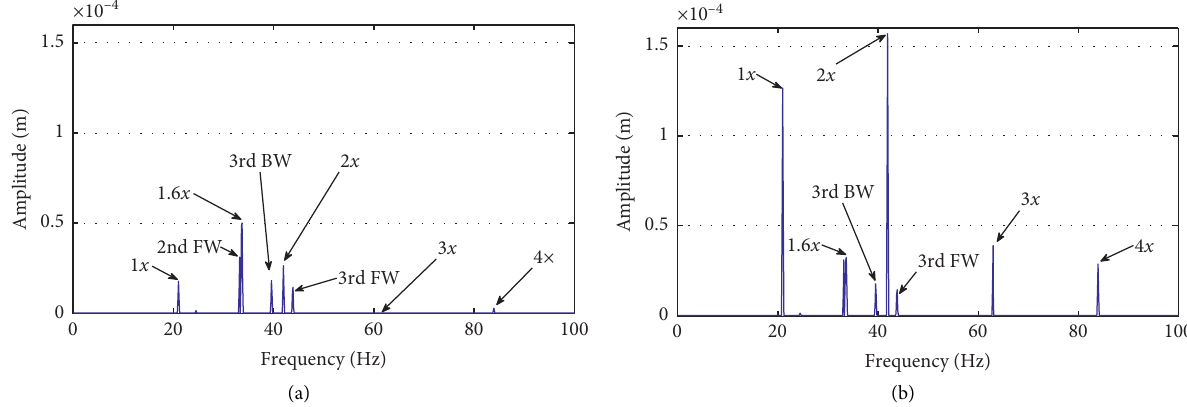
Figure 11: Spectrum of misalignment at bearing 1 (inner rotor): (a) horizontal direction and (b) vertical direction.